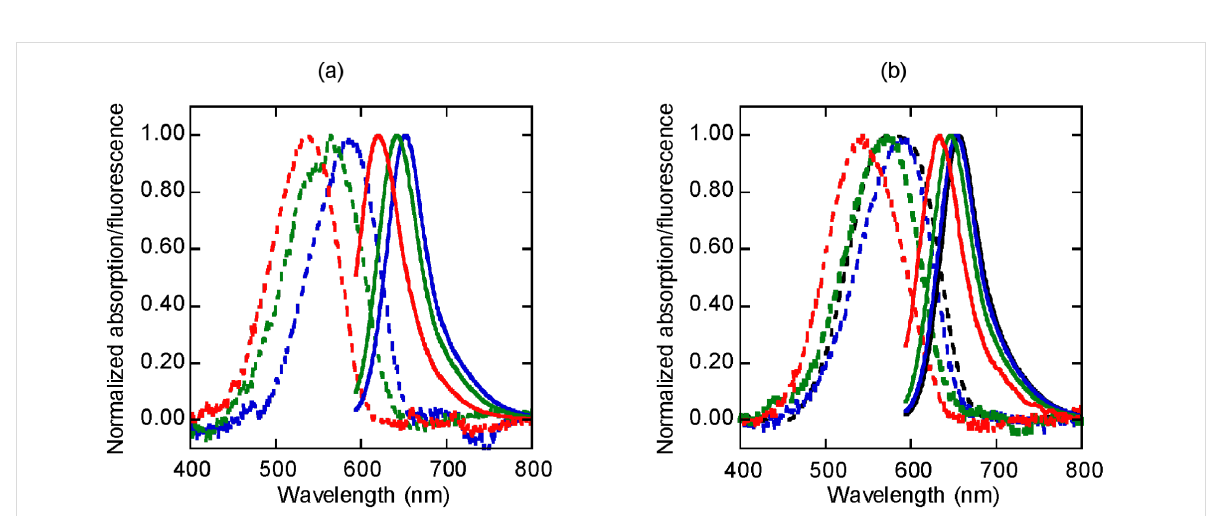
Figure 2: Normalized absorption (---) and fluorescence (––) spectra of (a) propargyl Nile red 1 and (b) Nile red-labeled acpcPNA 10mer-Nr in 10 mM sodium phosphate buffer (pH 7.0):acetonitrile: black = 100:0; blue = 80:20; green = 50:50; red = 0:100. All measurements were carried out in 10 mM sodium phosphate buffer (pH 7.0), [PNA] and [ 1 ] = 1.0 µM at 20 °C with λ ex = 580 nm.